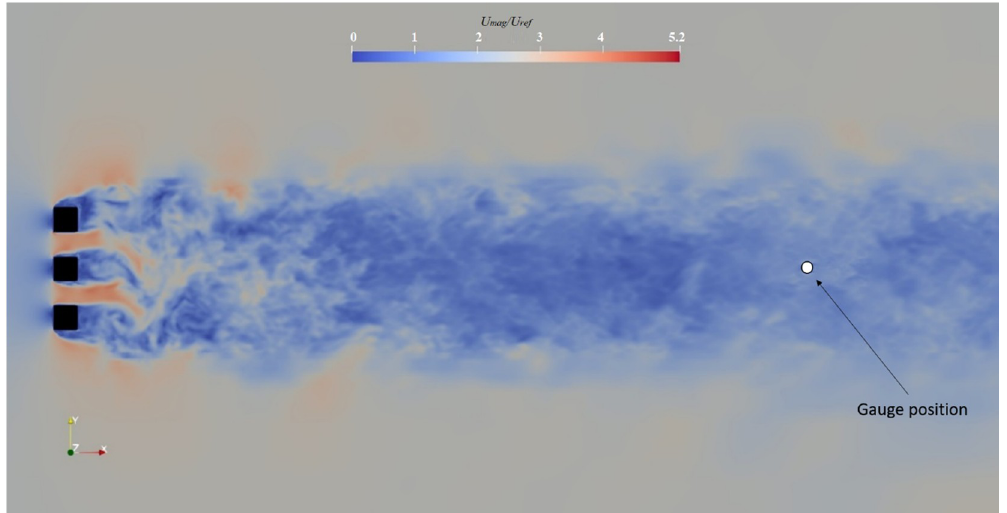
Figure 8. Normalized magnitude of the instantaneous flow velocity ( U mag / U ref ) in the horizontal plane ( x , y ) at the gauge collector elevation for the turbulent free-stream conditions.